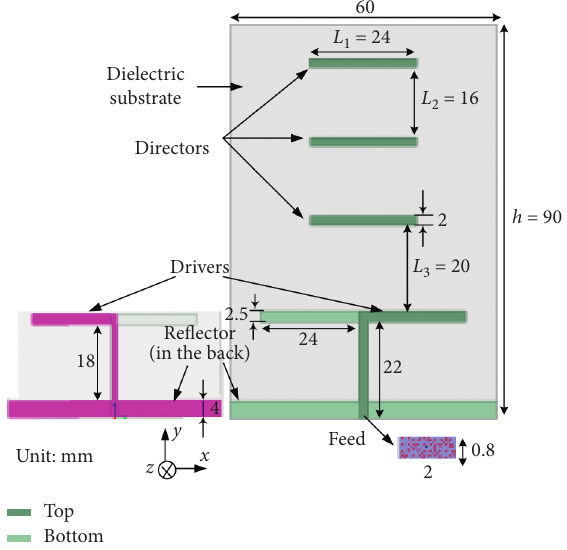
Figure 1: Layout and design parameters of the reference quasi-Yagi antenna with straight arms.